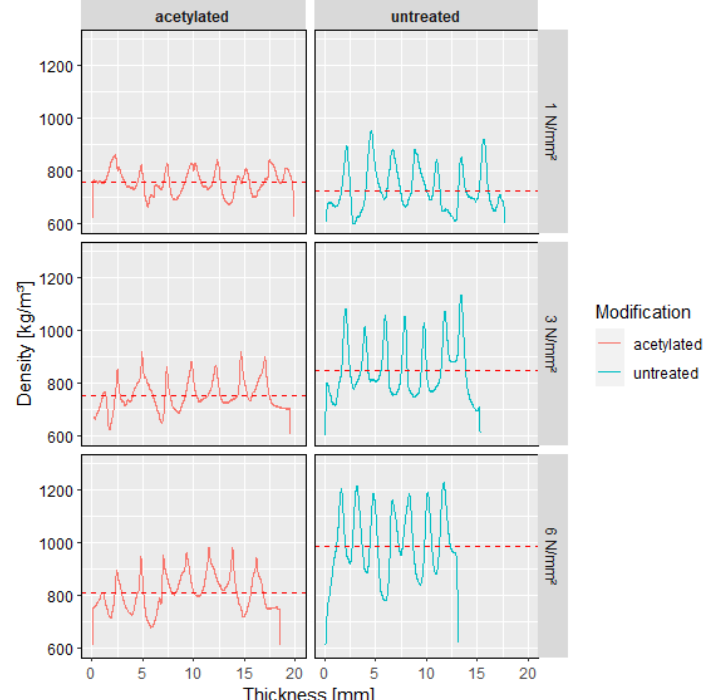
Figure 2. One representative density profile for acetylated LVL and untreated references bonded with 1, 3, and 6 MPa. The red–dotted lines show the mean values of each density profile.